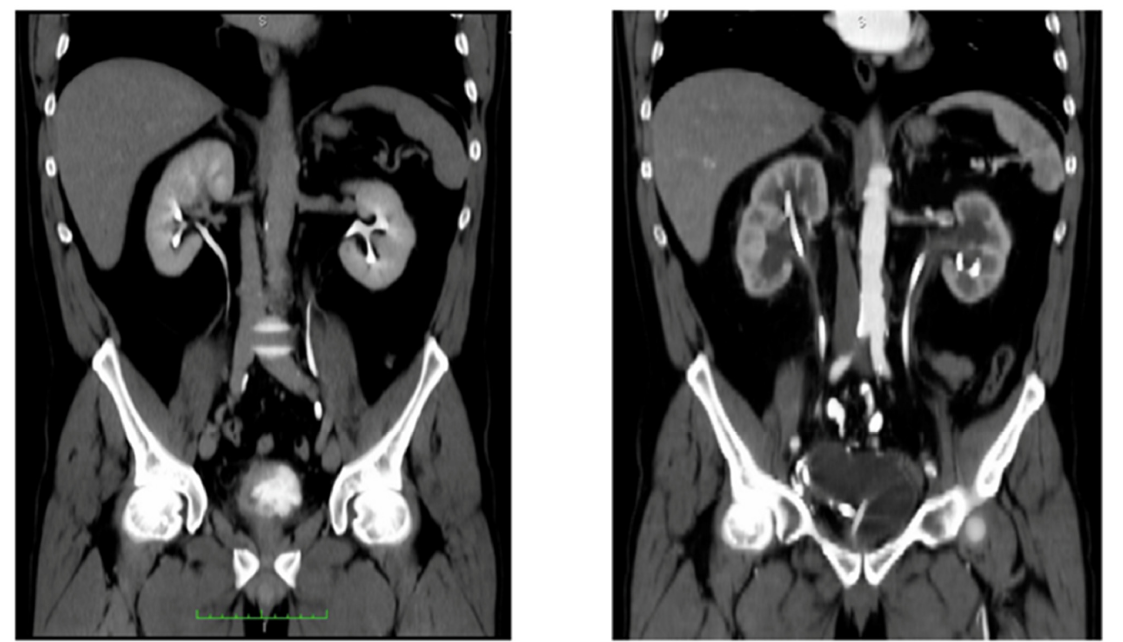
Figure 1. ( Left ) CT-urography showing pathological bladder thickening, later diagnosed as MIBC, with regular upper urinary tracts. ( Right ) CT scan, arterial phase, taken after development of bilat- eral ureteral-ileal stenosis with hydronephrosis treated at the previous institution with ureteral sten- tin. Green scale bar: cms. Green scale bar: cms.